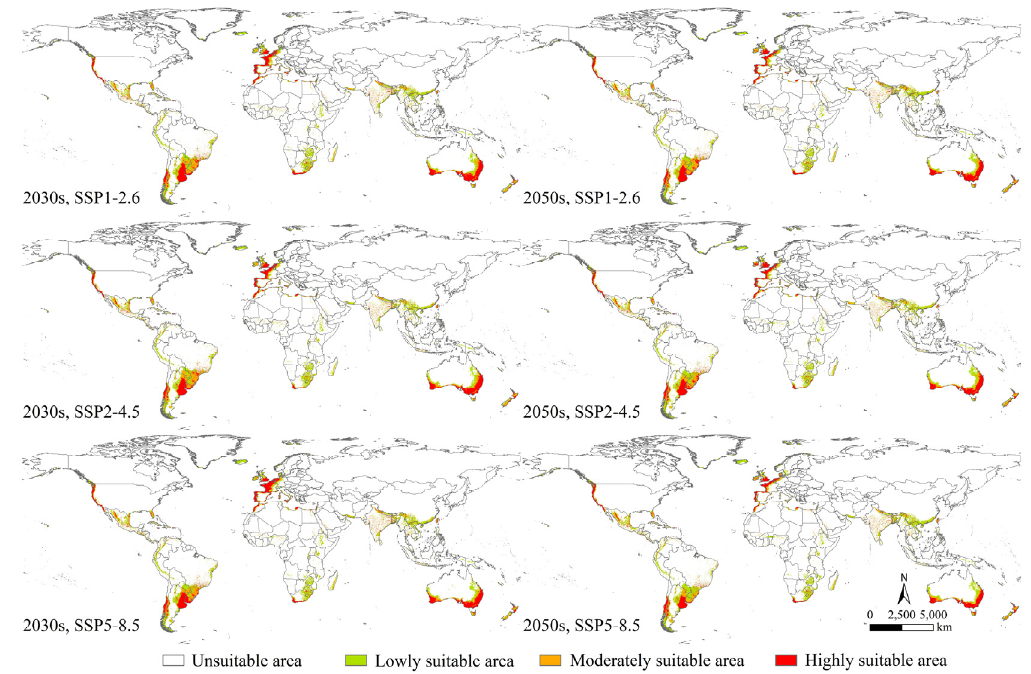
Figure 4. Potential geographical distribution of Phoracantha semipunctata under future climate (2030s and 2050s).